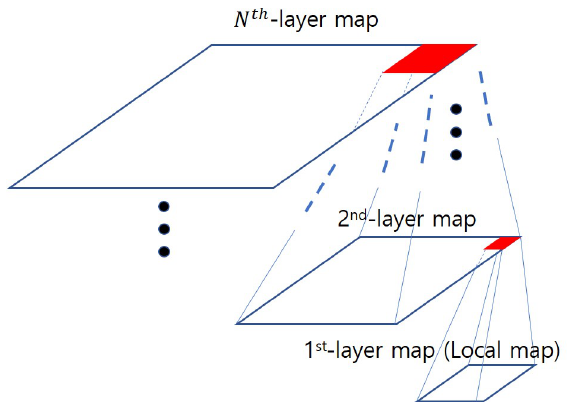
Figure 5. Concept of the Multi-Layer Hierarchical